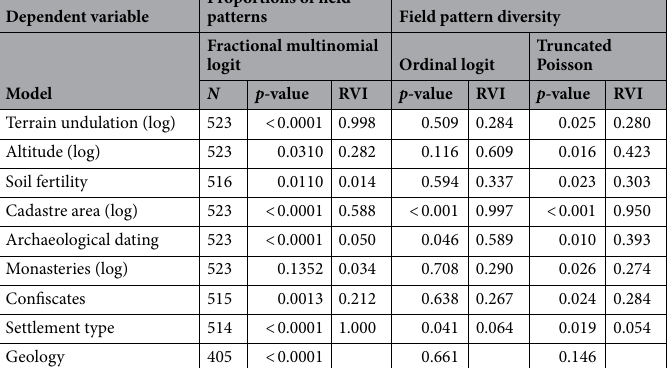
calculation, and for the regression tables, respectively. The geographical interpolation for Fig. 4 was performed in SAGA software 176 using the universal kriging tool.